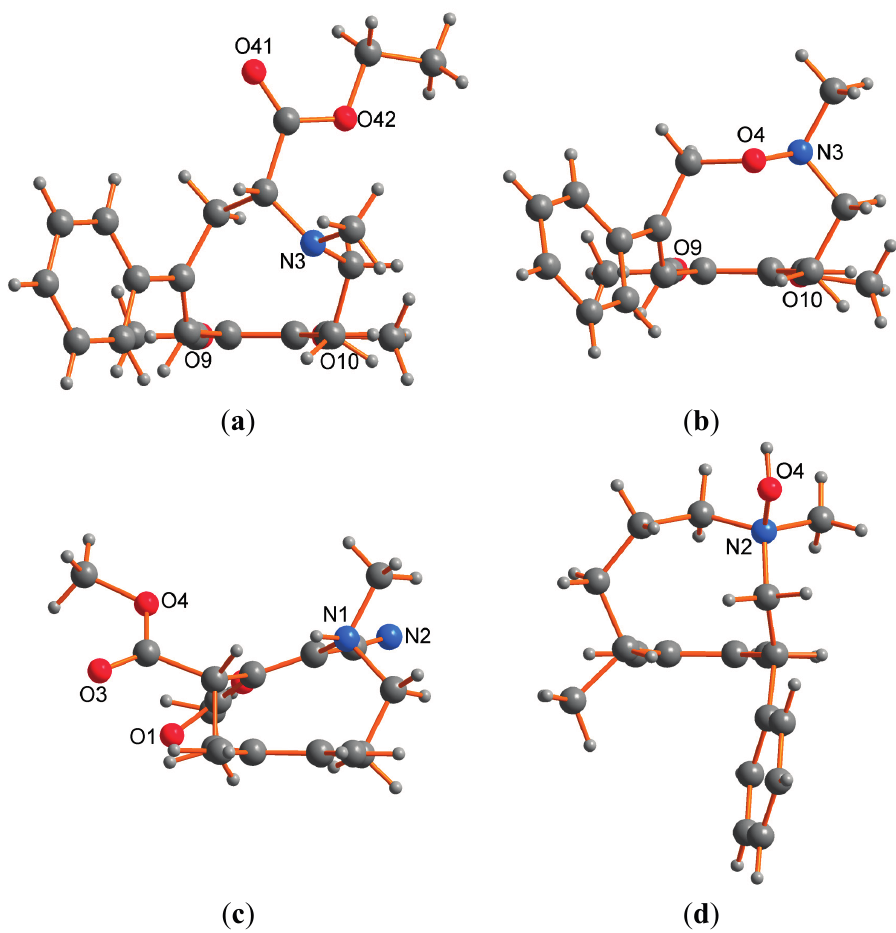
Figure 4. The molecular cores of E - 1 ( a ); 2 ( b ); AYEKOF [26] ( c ) and SELXUC [27] ( d ); projected through the parent aromatic ring as a “baseline” at the bottom of the “macrocycle” of each picture, and displaying the separate macrocycle